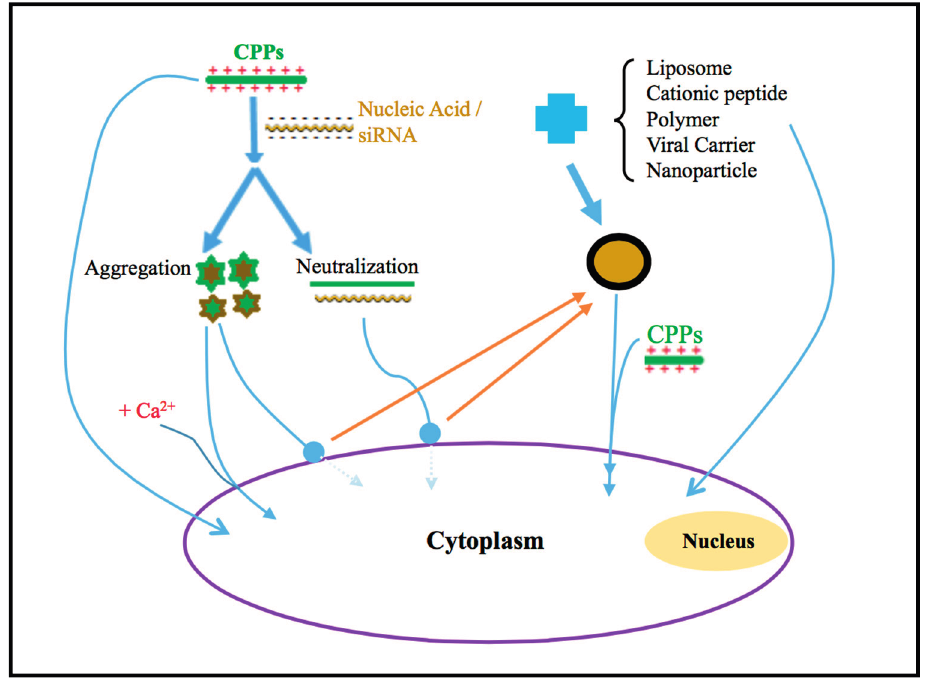
Figure 4. The potential use of CPPs. CPPs has been widely used as modulators or vehicles for the delivery of various biological products into cells. In order to overcome the neutralization and aggregation of CPPs that result in the inability to cross the cell membrane, calcium can be used to improve the nucleic acid delivery. The nucleic acids could be assembled with the typical drug carrier (e.g., liposome, cationic peptide, polymer, viral carrier and nanoparticle), and then be further modified with CPPs, consequently dramatically enhancing the nucleic acid transferring